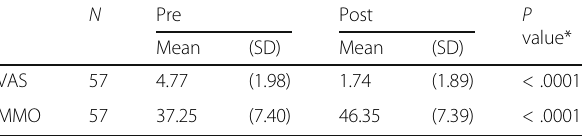
Table 2 Result of